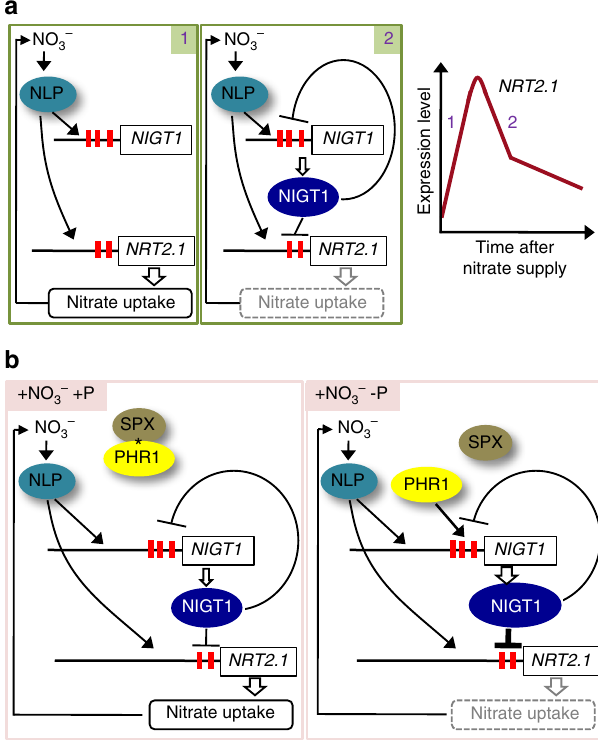
transcriptional cascade that modulates nitrate uptake in response to fl uctuations in the nitrate condition. Nitrate activates NLP, which directly upregulates both the NRT2 . 1 and NIGT1-clade gene promoters. Thus, NRT2 . 1 expression is initially activated (1) and then repressed by expression of NIGT1 - clade genes (2). Increases in NRT2 . 1 expression lead to enhanced uptake of nitrate as a substrate for nitrate assimilation and also a signal for activating NLP. The expression level of NRT2 . 1 is modulated by the balance of these positive and negative regulatory loops. b Model for the transcriptional cascade that integrates nitrate and P-starvation signalling pathways. When P nutrient (phosphate) is abundant, PHR1 is kept inactive by the SPX – inositol polyphosphate (*) complex. Thus, the nitrate-NLP cascade activates the NRT2 . 1 promoter independently of the PHR1 pathway. Upon P depletion, PHR1 is freed and enhances the expression of NIGT1- clade genes, leading to reductions in both NRT2 . 1 expression and nitrate